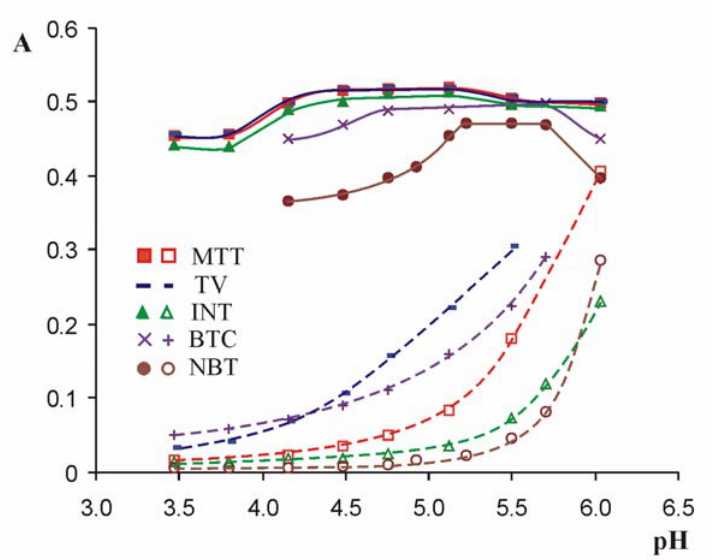
Fig. 2 Absorbance of V(V)-TAR-TS extracts against TAR-TS extracts (—) and TAR- TS extracts against chloroform (- - -) vs. pH of the aqueous phase plots. C